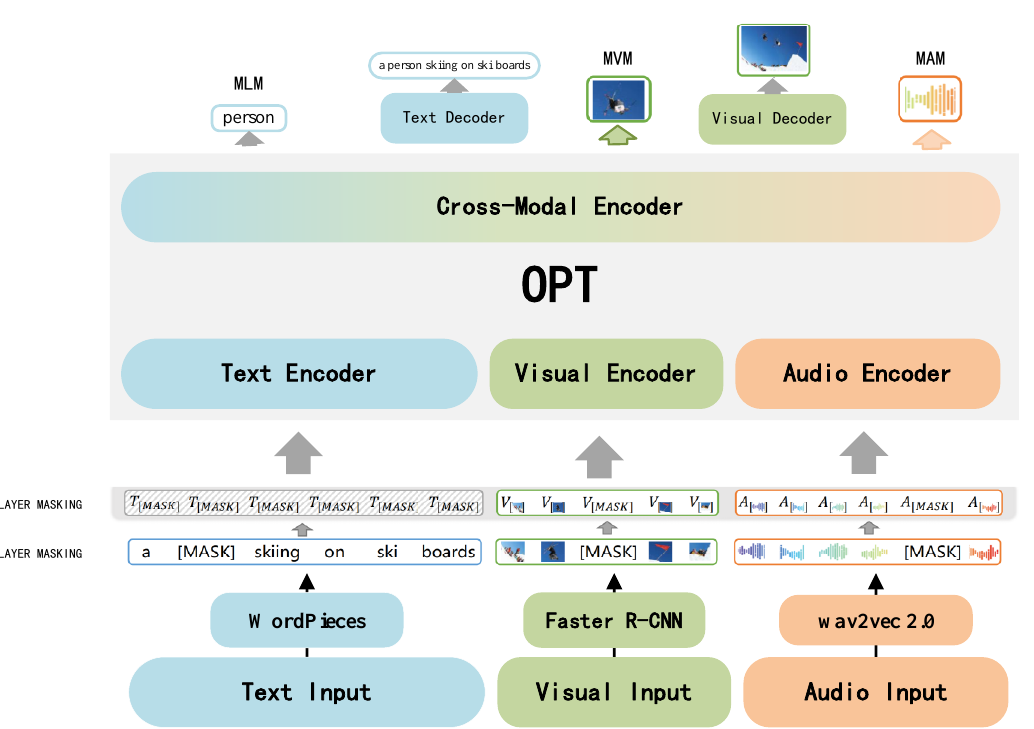
Figure 6. Overview of OPT architecture.